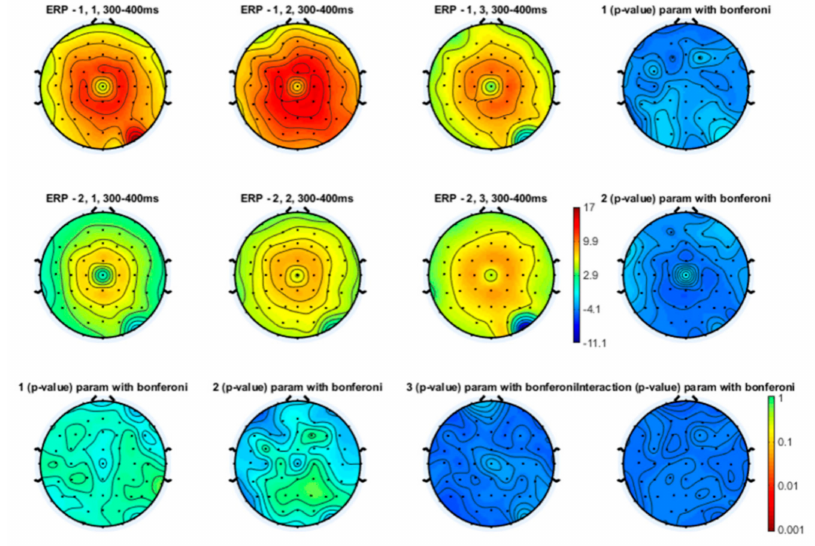
Figure 11. Topographical representation of the P2 component on the left hand stimulation. The first line of topographical maps represents the P2 amplitude in the baseline condition, slow finger tapping (SFT) and fast finger tapping (FFT) in the control group. The second line of maps represents the P2 amplitude in the baseline condition, slow finger tapping (SFT) and fast finger tapping (FFT) in the patient group. The control group’s basal condition (1,1), slow finger tapping (1,2) and fast finger tapping (1,3); the fibromyalgia (FM) group’s basal condition (2,1), slow finger tapping (2,2) and fast finger tapping (2,3) (see also Figure 1). The results of the repeated measures analysis of variance (ANOVA) corrected with the Bonferroni test are